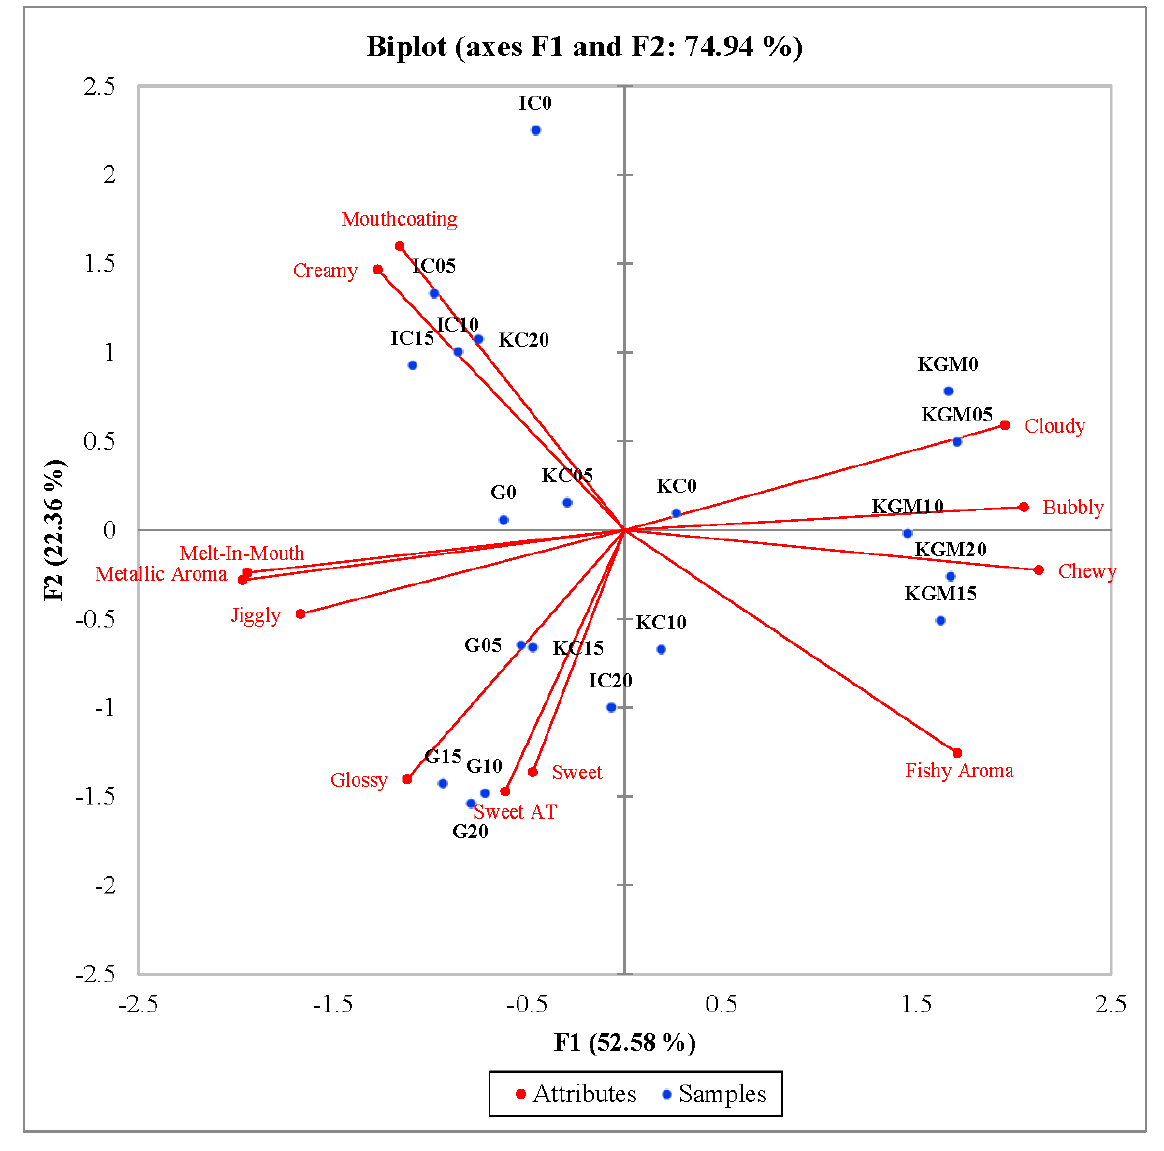
Figure 1. Principal components analysis biplot of Factors 1 and 2 by the correlation matrix of mean 12 sensory attributes across the 20 model confectionary gel samples based on Gel Type. AT = aftertaste, G = gelatin, IC = ι -carrageenan, KC = κ -carrageenan, KGM = konjac glucomannan. The biplot of PC1 vs. PC2 from the PCA of the matrix of significant sensory attributes across model confectionary gel samples based on sugar concentration is shown in Figure 2. The PCA explained 88.50% of the variation in which PC1 and PC2 explained 50.76% and 37.74% of variance, respectively. Regardless of the sugar concentration, konjac glucoman- nan samples were highly characterized by chewy and cloudy. Most gel samples without sugar were characterized by bitter taste. Without the masking effect of sugar, the bitterness of the samples was more easily perceived by panelists. Surprisingly, the samples with the highest sugar concentration did not correlate with a sweet or sweet aftertaste, indicating that with the addition of sugar, other factors, such as the textural attributes, better explained the samples. Texture is a main determinant in the perception of sweetness and flavor release in products, as samples with the same sugar concentration can be perceived with different intensities of sweetness depending on hardness and fracturability [36,37]. Similar results were found in studies which attempted to replace sugar with alternative sweeteners